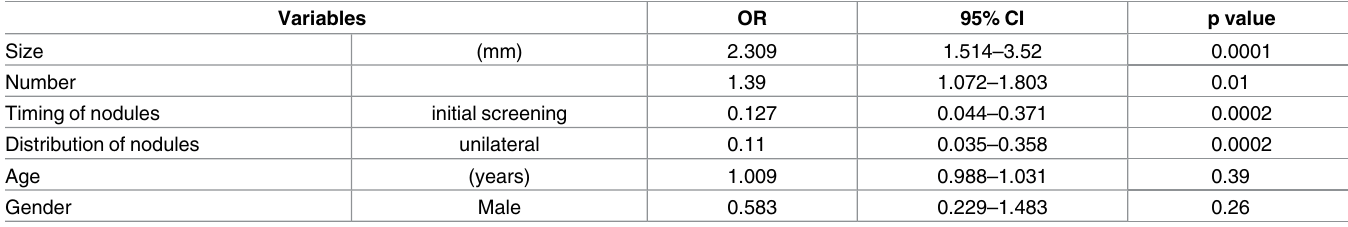
Table 2. Logistic univariate analysis for diagnosis of pulmonary nodules.